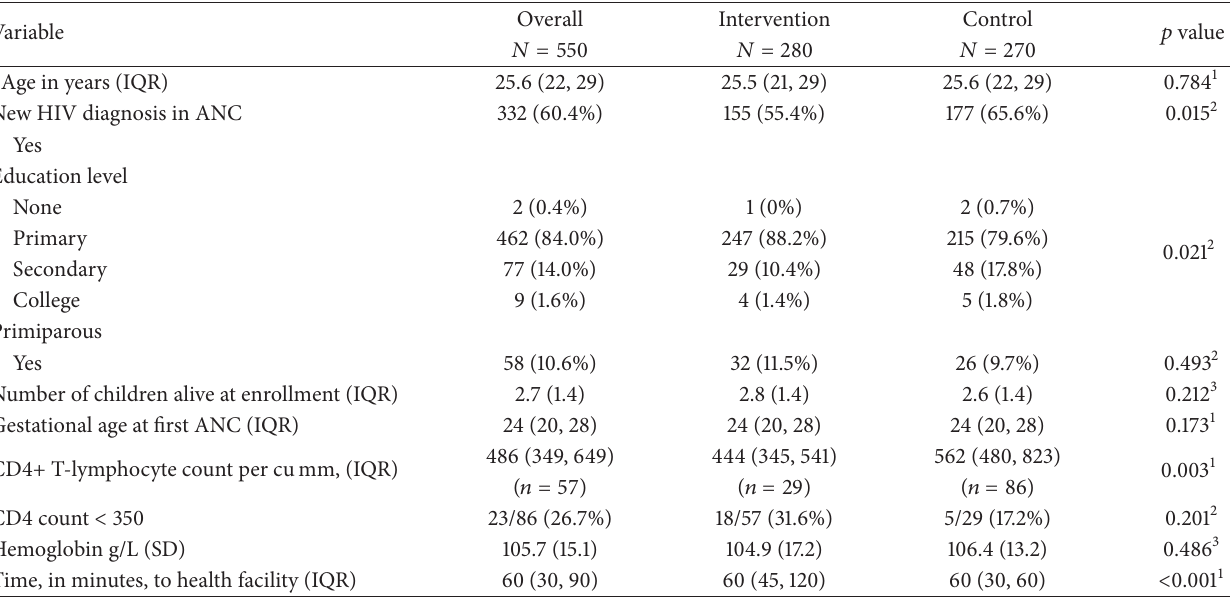
Figure 1: Site randomization and participant flow from screening and enrollment and through follow-up. Table 1: Study population baseline